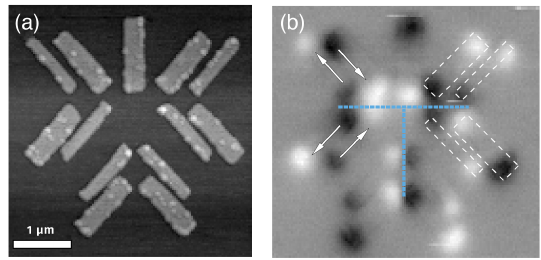
Figure 7: (a) Atomic force microscopy (AFM) of a T-junction setup with three Drag- onfly magnet configurations. Magnetic film thickness is 20 nm. (b) Magnetic force microscopy (MFM) data on a different T-Junction of the same design. Arrows indi- cate magnetization direction, white dashed lines are example of magnet dimensions. Blue dashed line is where the Majorana nanowire is envisioned. The magnetic his- tory was a magnetizing field from 100 mT to -16 mT to 0 mT applied at 45 degree direction, then 100 mT to -16 mT to 0 mT at 135